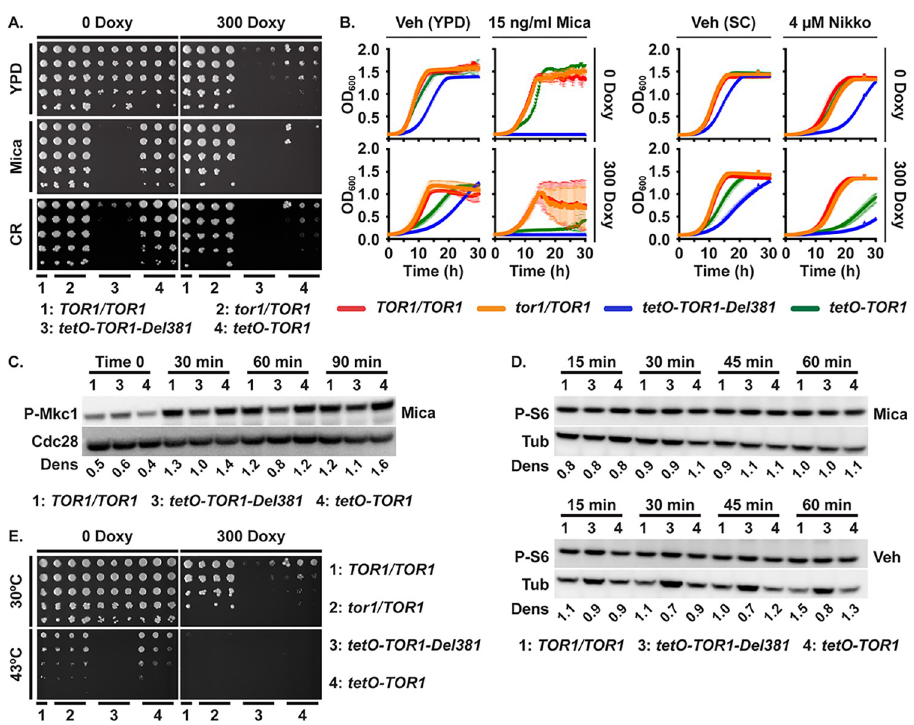
Fig 7. Tor1 N-terminal HEAT repeats were required for adequate cell wall- and heat stress responses. A, E. Dilutions of cells of indicated genotypes were spotted on YPD medium without or with 300 ng/ml doxycycline (300 Doxy), cell wall stress was induced with 10 ng/ml micafungin (Mica) or 15 μ g/ml Congo red (CR) ( A ), and heat stress was induced at 43 o ( E ); strains TOR1/TOR1 , JKC1361 for YPD and micafungin and JKC1713 for Congo red and heat stress; tor1/TOR1 , JKC1345, JKC1346, JKC1347; tetO-TOR1-Del381 , JKC1442, JKC1445, JKC1441; tetO-TOR1 , JKC1543, JKC1546, JKC1549). B. Cells of indicated genotypes were grown in YPD medium containing Vehicle (H 2 O) or 15 ng/ml micafungin (Mica), without or with 300 ng/ml doxycycline (left panel); or in synthetic complete medium (SC) containing Vehicle (H 2 O) or 4 μ M nikkomycin (Nikko), without or with 300 ng/ml doxycycline (right panel). Strains TOR1/TOR1 , JKC1713; tor1/TOR1 , JKC1347; tetO-TOR1-Del381 , JKC1441; tetO-TOR1 , JKC1549. Error bars show SD of 3 technical replicates. C, D. Cells of indicated genotypes were pre-grown in YPD medium with 5 ng/ml doxycycline for 3.5 h (Time 0) and then diluted into fresh YPD medium with 5 ng/ml doxycycline with either 10 ng/ml micafungin (Mica) or H 2 O as vehicle (Veh, D lower panel is the same P-S6 blot as Fig 1B). Total protein extract was probed with antibody to phosphorylated Mkc1 (P-Mkc1) and the PSTAIRE antigen of Cdc28 as loading control ( C ), or with antibody to phosphorylated Rps6 (P-S6) and tubulin (Tub) as loading control ( D ). Dens: signal intensity ratio of P-Mkc1 to Cdc28 ( C ) or P-S6 to Tub ( D ); strains TOR1/TOR1 , JKC1713; tetO-TOR1-Del381 , JKC1441; tetO-TOR , JKC1549. Representative of 2 biological